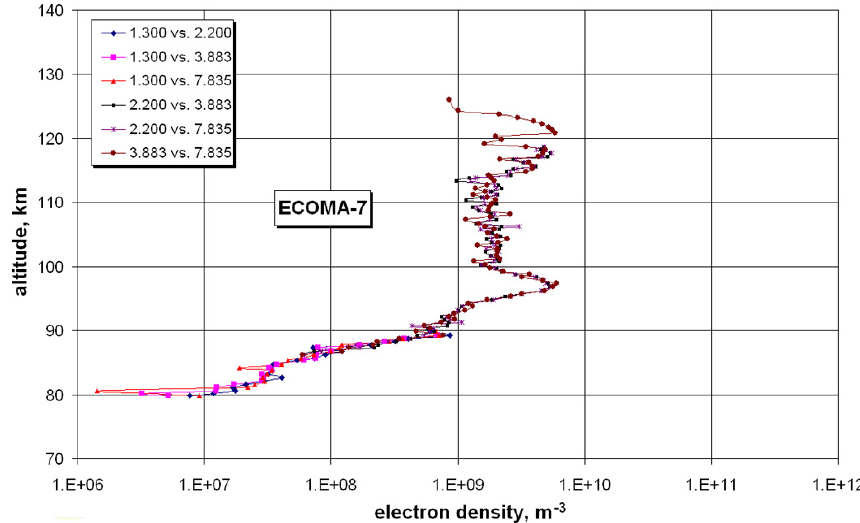
Fig. 2. Electron densities from the radio wave propagation experiment (flight ECOMA-7). In this flight all results are based on differential Faraday rotation, e.g. 2.200 vs. 3.883